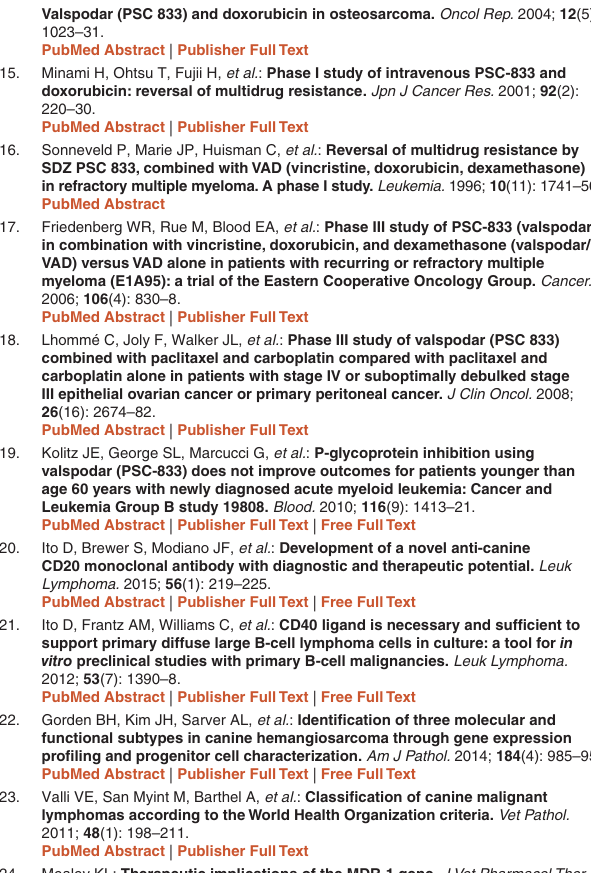
Supplemental Table 1. Differentially expressed genes (DGE) from Cuffdiff analysis between pre and post placebo treatment groups. Cuffdiff analysis was based on FPKM (fragments per kilobase of transcript per million reads and false discovery rate, FDR q < 0.05). Pre-treatment samples were given the “sample_1” label and post-treatment samples were given the “sample_2” label for testing for group differences. An “OK” test status means that the test was successful. The “value_1” is the Cuffdiff computed FPKM of the sample_1 group whereas the “value_2” is the Cuffdiff computed FPKM of the sample_2 group. The log2 (fold_change) is the (base 2) log fold change of FPKM /FPKM . The test statistic is the value of the test statistic used to compute significance of the observed change in FPKM. value_1 value_1 The q value is the FDR-adjusted p-value and “yes” in the significance column means that the p value was less than the q value after Benjamini-Hochberg correction for multiple testing. Supplemental Table 2. Differentially expressed genes (DGE) from Cuffdiff analysis between pre and post valspodar treatment groups. Cuffdiff analysis was based on FPKM (fragments per kilobase of transcript per million reads and false discovery rate, FDR q < 0.05). The locus is the genomic coordinates for the gene that was tested. Pre-treatment samples were given the “sample_1” label and post-treatment samples were given the “sample_2” label for testing for group differences. An “OK” test status means that the test was suc- cessful. The “value_1” is the Cuffdiff computed FPKM of the sample_1 group whereas the “value_2” is the Cuffdiff computed FPKM of the sample_2 group. The log2 (fold_change) is the (base 2) log fold change of FPKM /FPKM . The test statistic is the value of the test value_1 value_1 statistic used to compute significance of the observed change in FPKM. The q value is the FDR-adjusted p-value and “yes” in the signifi- cance column means that the p value was less than the q value after Benjamini-Hochberg correction for multiple testing. Click here to access supplementary